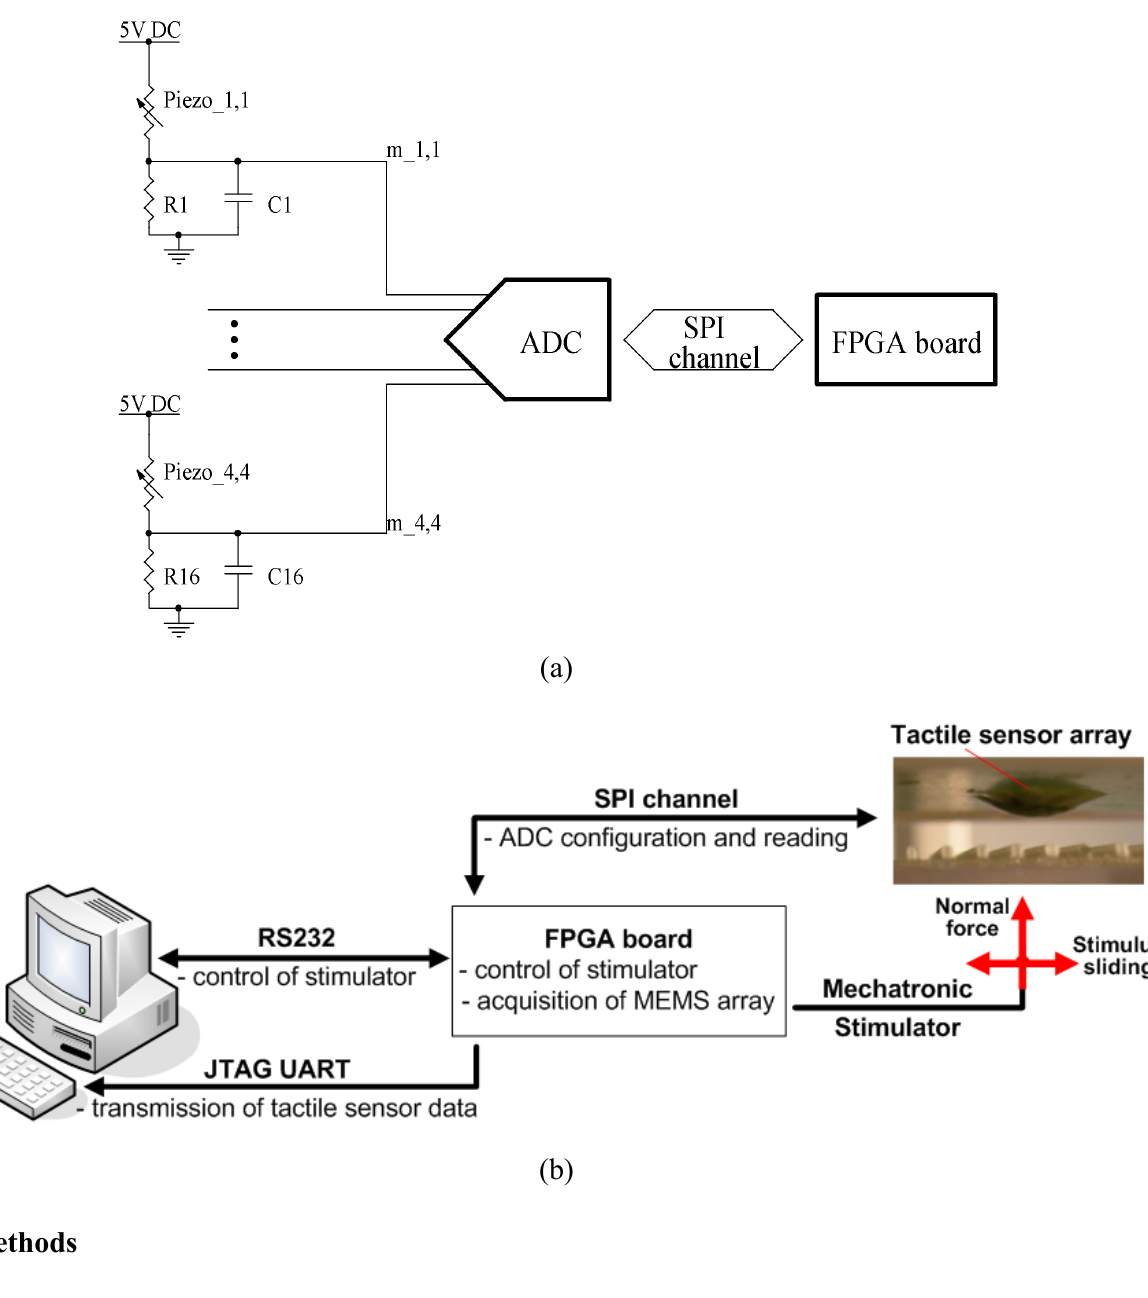
Figure 2. Schematic view of the readout electronics (a). Block diagram of the overall experimental setup